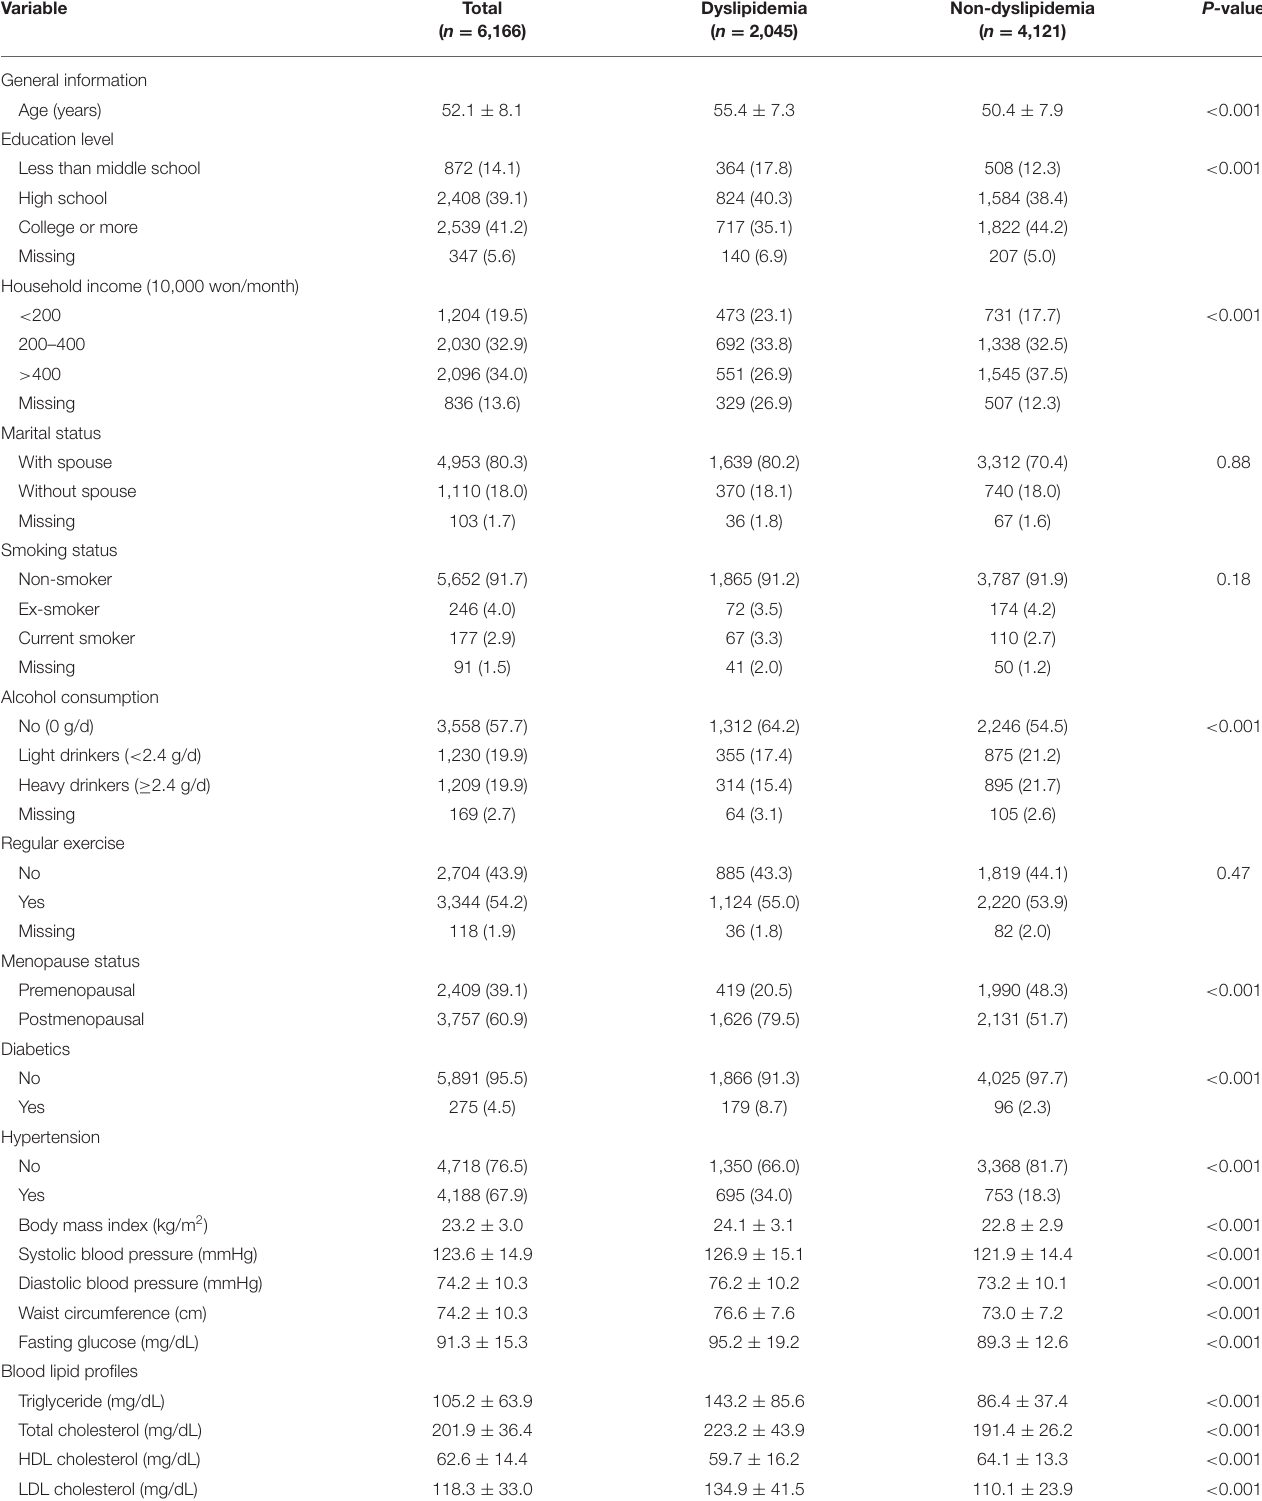
TABLE 1 | General characteristics according to dyslipidemia status.